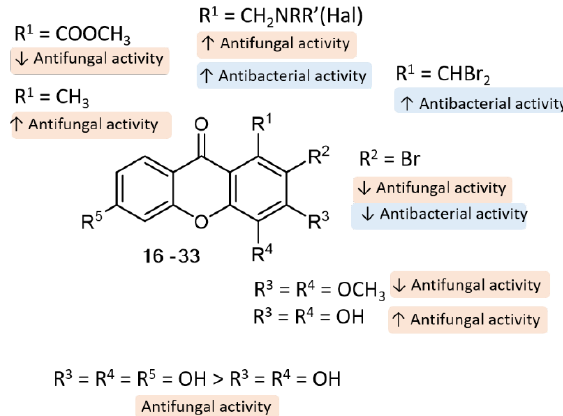
Figure 6. Putative SAR for the antibacterial and antifungal activity of xanthone analogues.